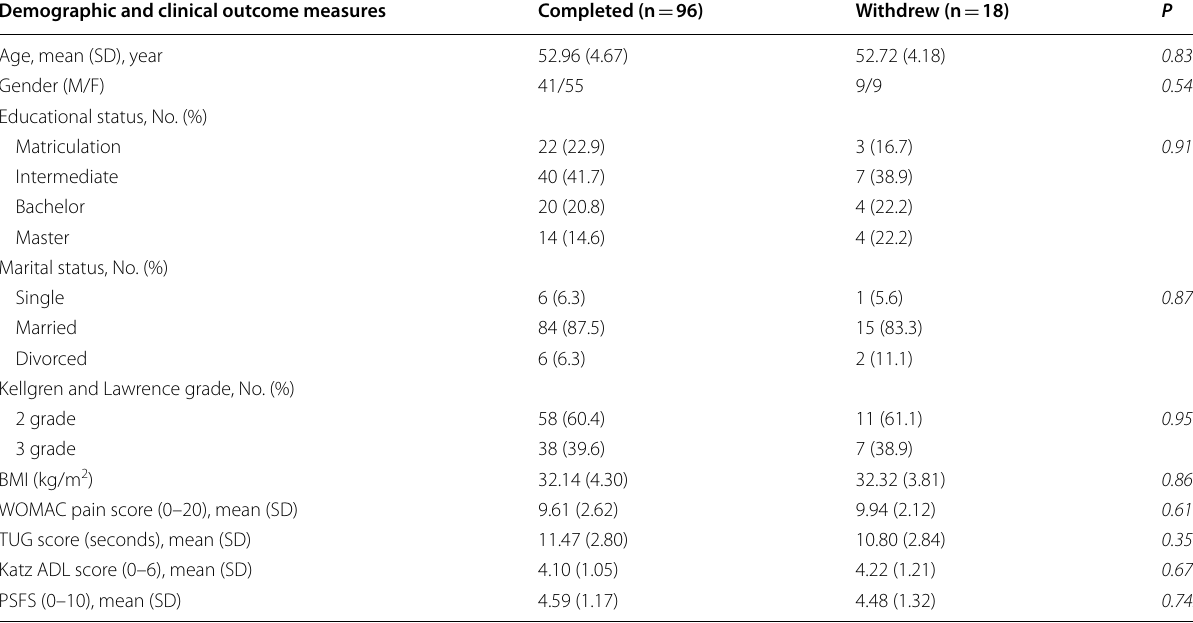
WOMAC, Western Ontario and McMaster Universities Osteoarthritis Index; SD, standard deviation; BMI, body mass index; TUG, timed up and go; ADL, activities of daily living; PSFS, patient specific functional scale; n,